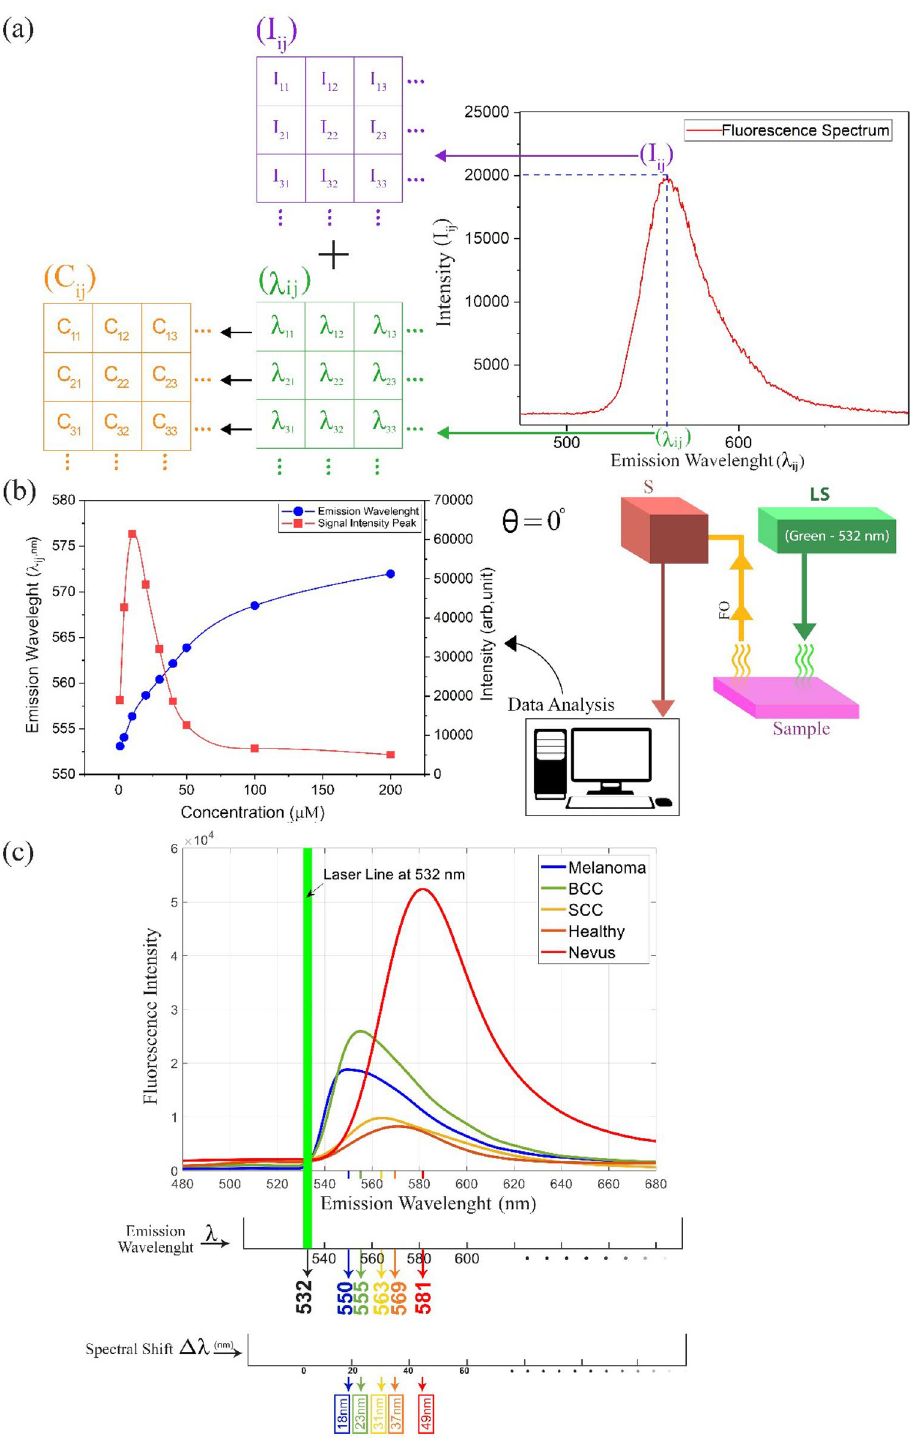
Figure 1. ( a ) Schematics of fluorescence emission micrographs based on m × n pixels. Each pixel owns its fluorescence spectrum, including max signal magnitude at a specific emission wavelength peak. After noise mitigation and image processing, the intensity and emission wavelength matrices lead to the tissue mapping. ( b ) Left: Emission wavelength and signal intensity versus Rd6G concentration ( µ M ) at the parallel incident. Right: laser-induced fluorescence (LIF) spectrometry at the parallel incident arrangement. Note that the spectra taken from the parallel arrangement are slightly different from the right-angle array. ( c ) Typical spectra and the corresponding spectral shift of nonmelanoma/melanoma lesions and normal/nevus tissues. The melanoma covers 550 ± 2 nm spectral shift (with respect to laser line) typically denotes 18 nm, nonmelanoma ranges 553–565 nm where BCC takes 555 ± 3 nm (23 nm), SCC corresponds to 563 ± 3 nm (31 nm). Similarly, normal tissues include an emission wavelength ∼ 570 ± 3 nm (37 nm), and nevus involves a wide range of emission wavelengths longer than 575 nm having 10 nm width (49 nm). Rd6G, Chemical formula, C 28 H 31 N 2 O 3 Cl, Molar mass,479.02 g/ mol, Density, 1.26 g/cm 3 , Solubility in water, 20 g/l (25 °C), Absorption peak 530 nm, Emission spectra 540–560 nm. Here, the parallel arrangement is used in SSFM such that S spectrometer, LS laser source, OF optical